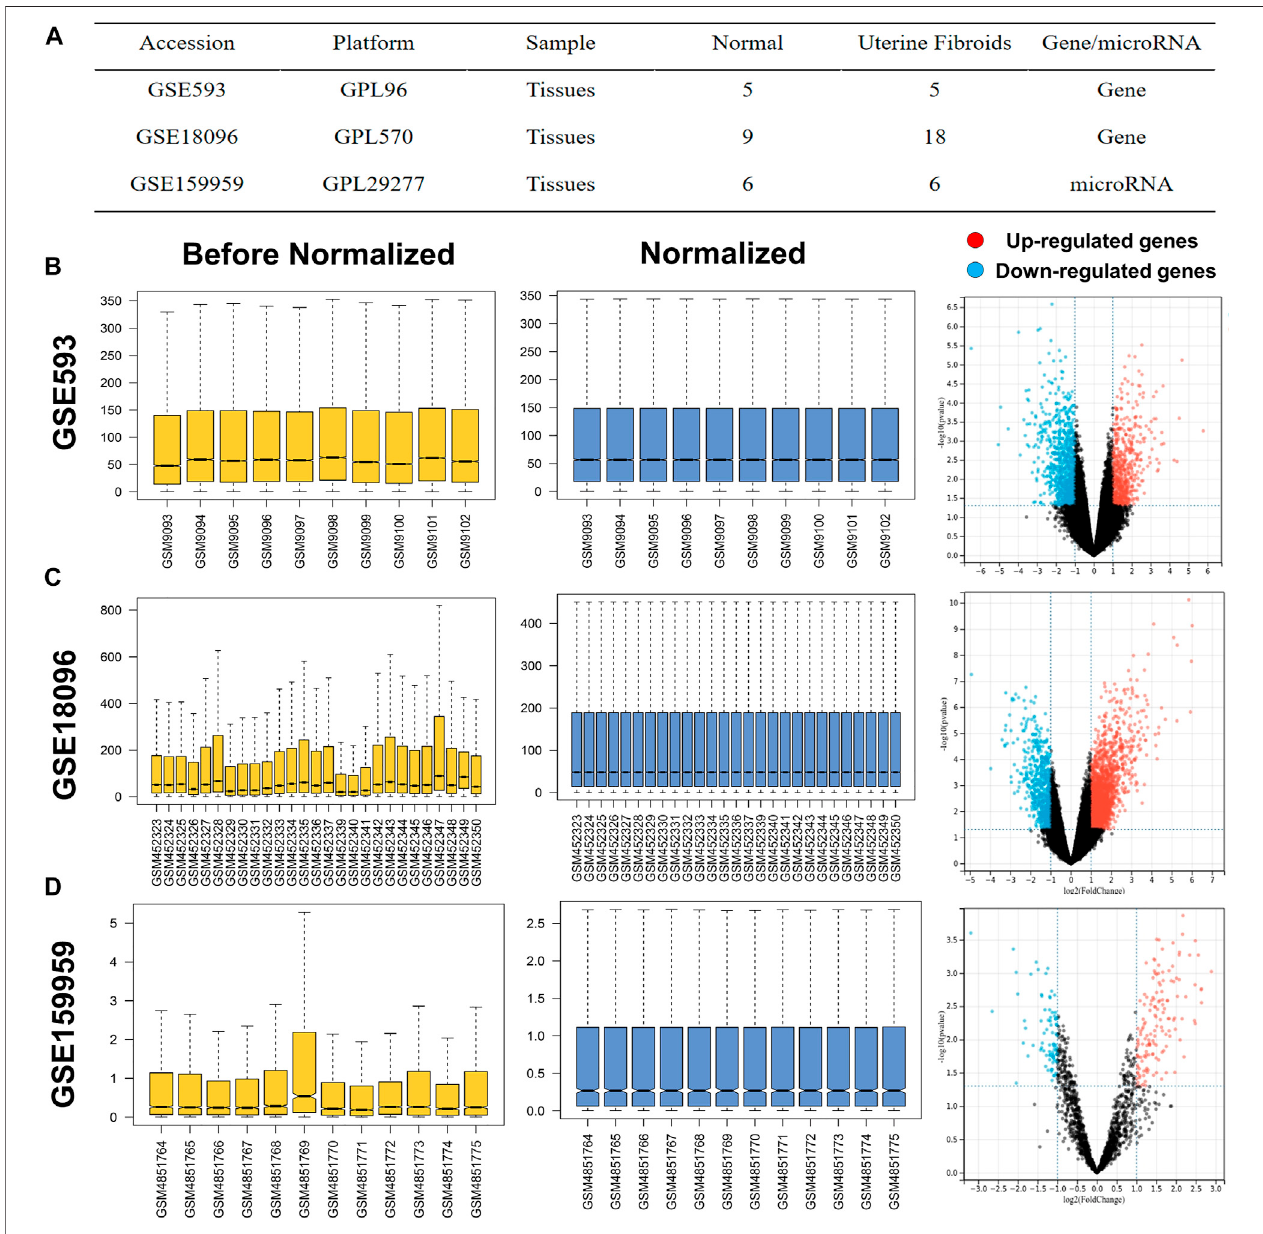
FIGURE 1 | (A) Characteristics of mRNA and miRNA expression pro fi les of UF. The before and after normalization and volcano plots of (B) GSE593, (C) GSE159959 and (D) GSE18096.